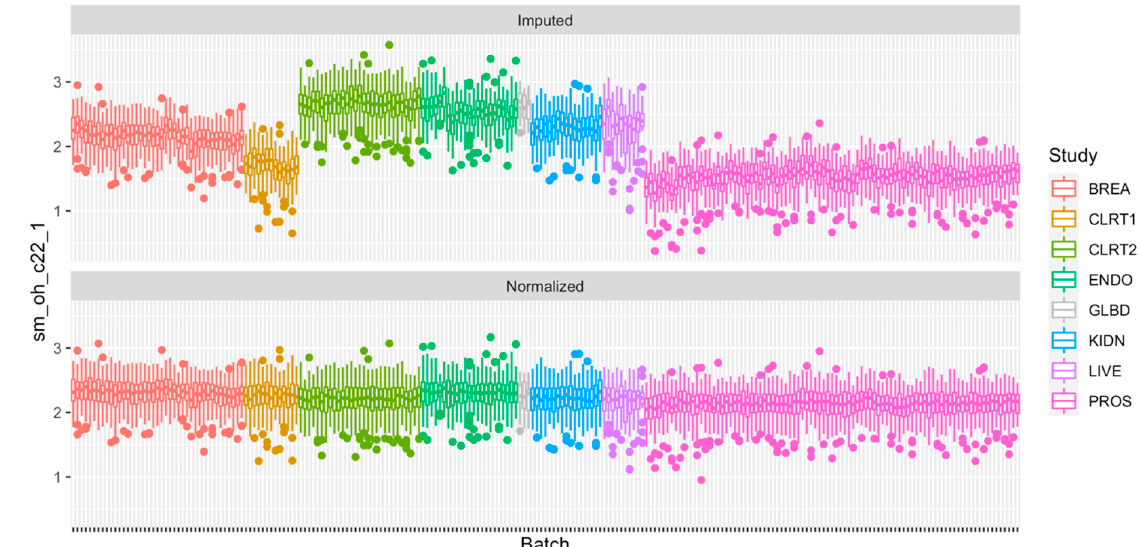
Figure 3. Boxplots of SM OH C22:1 within each of the batches of the eight case-control studies for the imputed data ( top ) and the normalized data ( bottom ). Dots indicate measurements out of the interval (q1 − 1.5 × IQR, q3 + 1.5 × IQR) with q1 and q3 being the first and third quartile, respectively, and IQR = q3 − q1 the interquartile range. In each plot, the y − axis represents the value of the measurement and the y − axis represents each batch, arranged by study.